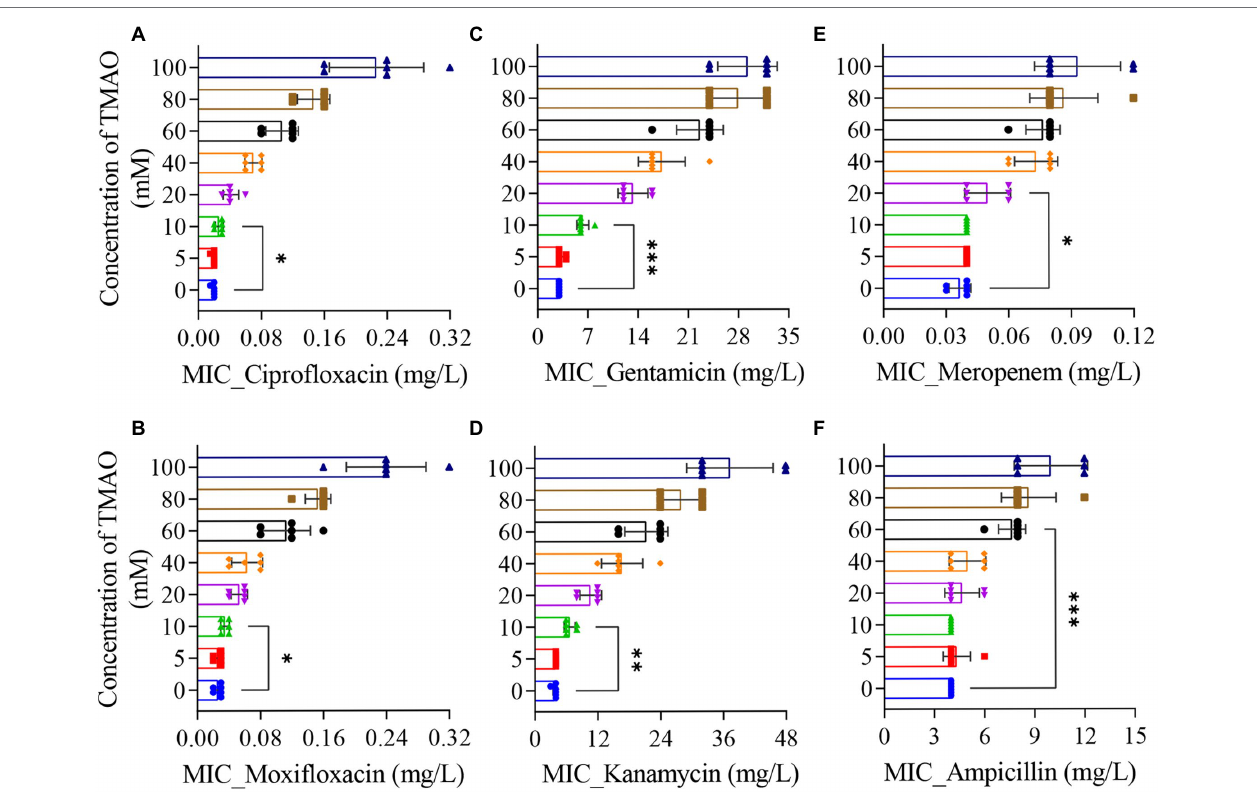
FIGURE 1 | Effect of Trimethylamine N-oxide (TMAO) on minimum inhibitory concentration (MIC) of antibiotics. (A–F) MIC was determined by the 2-fold broth dilution method. Cultures incubated to OD 600 = 0.2 were diluted to ~10 5 cells/ml, mixed with various amounts of drug, and incubated at 37 ° C for 12 h. As needed, different concentrations of TMAO were added to the LB medium. Six individual experiments were performed. Each data plotted value represents mean ± SD. Significance determined by paired t -test. * p < 0.05; ** p < 0.01; *** p <